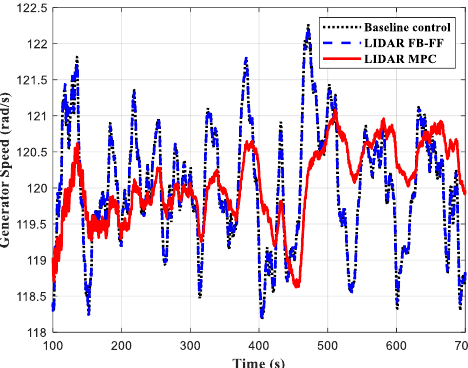
Figure 5. Tower fore-aft acceleration: ( a ) time profiles; ( b ) cumulative PSD (for wind speed with 5% turbulence intensity).